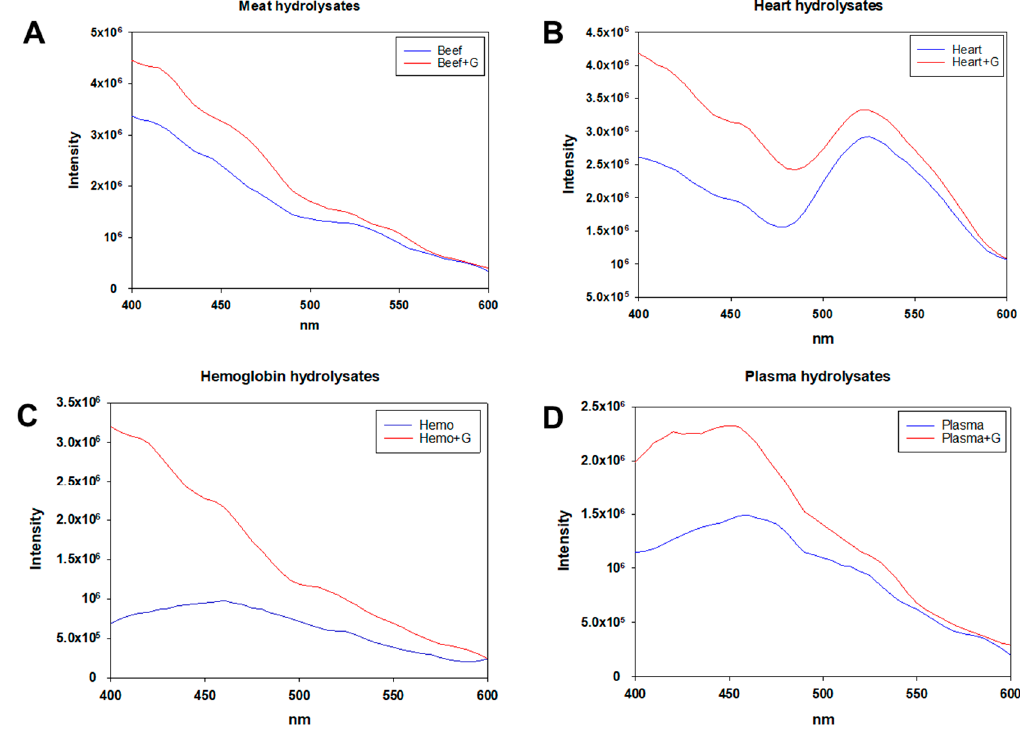
Figure 2. Fluorescence spectra of hydrolysates with (red) or without (blue) glucosamine (G) of ( A ) bovine meat, ( B ) bovine heart, ( C ) porcine hemoglobin, and ( D ) porcine plasma.